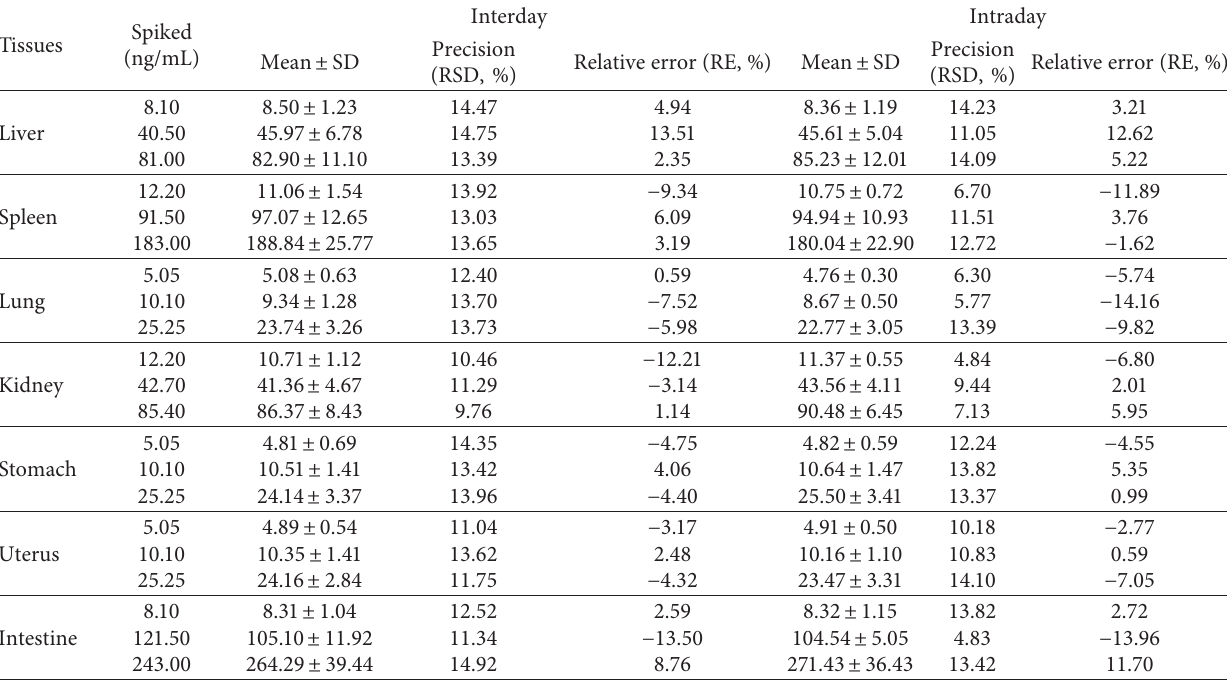
Table 9: Interday and intraday precision and accuracy data for assays of kaempferol in different tissues ( n � 6).